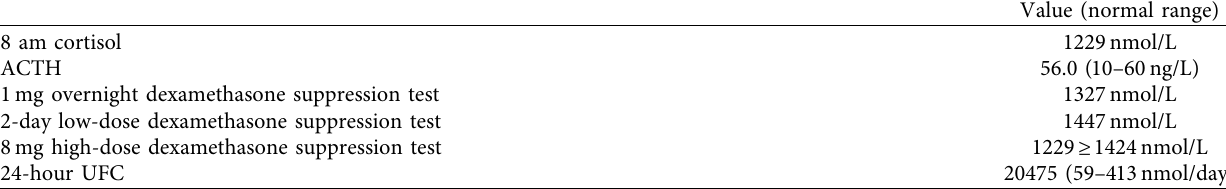
Table 2: Diagnostic workup for hypercortisolism.